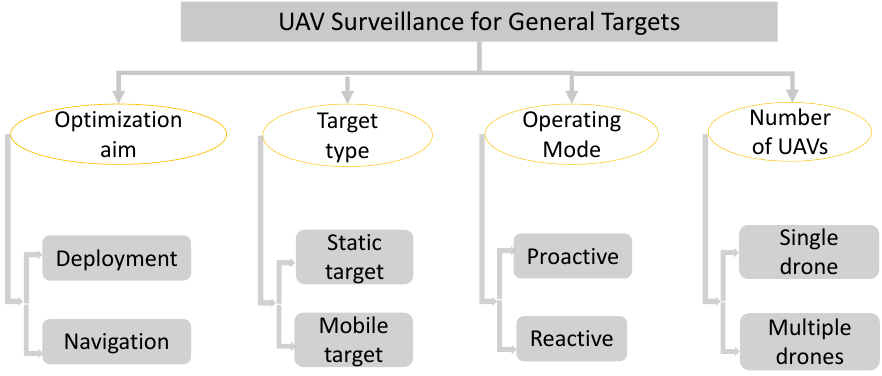
Figure 4. Summary and taxonomy of previous studies on UAV surveillance for general